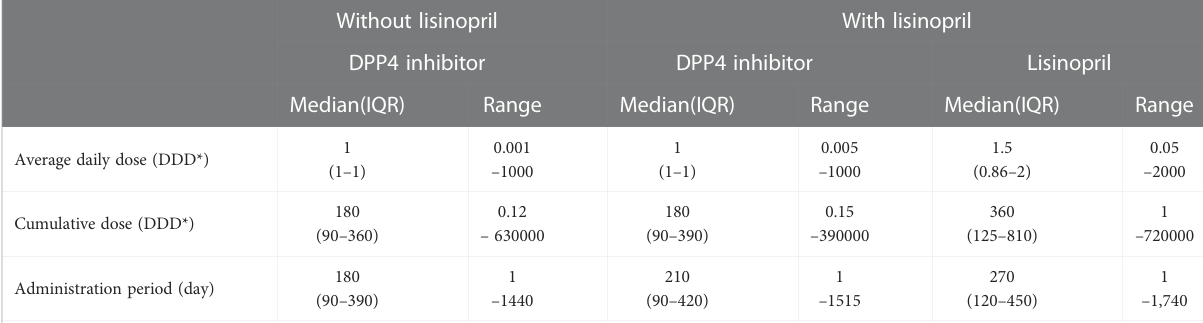
TABLE 5 Daily and cumulative doses and administration periods of DPP4 inhibitors and lisinopril in the propensity score-matched